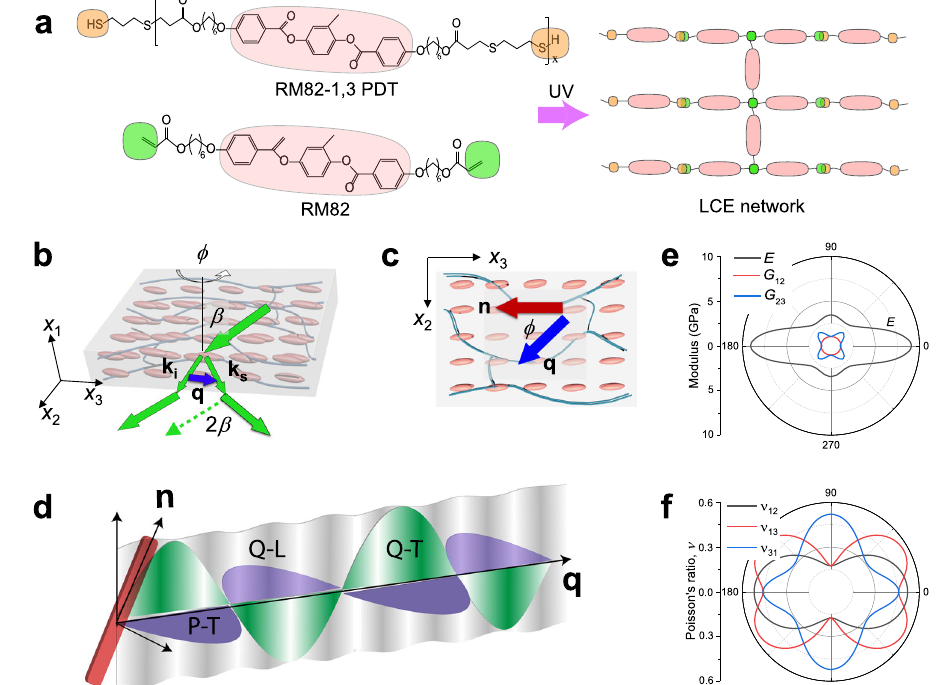
Fig.1|LCEandphononpropagationschematic.a SchemeofLColigomer,RM82- 1,3 PDT, and diacrylate-based reactive mesogens, RM82, in preparation of LCE network, where the crosslinking sites were introduced via the thiol-acrylate reac- tion between RM82-1.3 PDT and RM82. b Scheme of the transmission scattering geometryusedintheBLSexperiments.Asthescatteringangleistwicetheincident angle β , the phonon wave vector q = k i -k s is parallel to the ( x 2 , x 3 ) fi lm plane where LCs are aligned, k i and k s being wave vectors of the incident and scattered